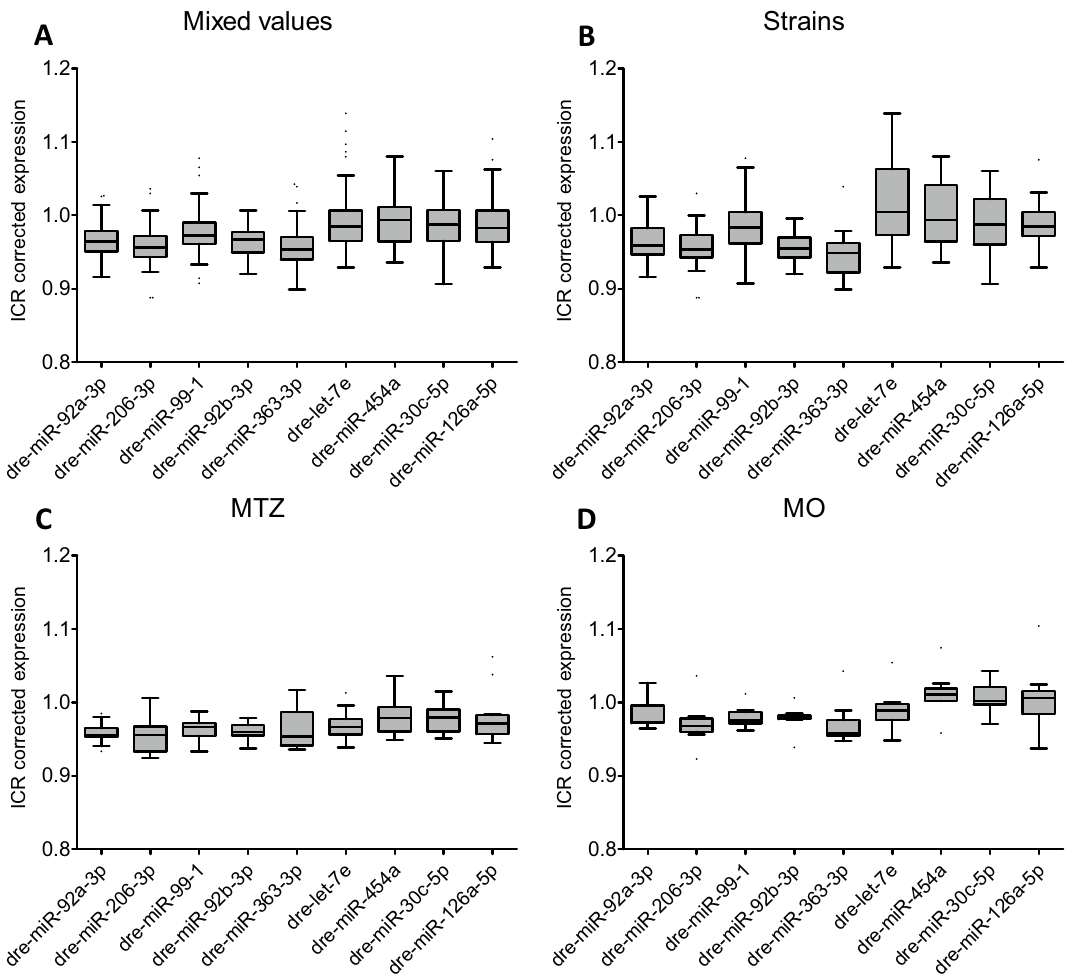
Figure 3. Abundant expression of candidate as endogenous control miRs. All miR candidates were detectable in the whole sample set. In general, they exhibit a high homogeneity as indicated by low standard deviations (SD). MiR-92b-3p shows most homogenous expression levels in mixed values ( A ), strains only ( B ), MTZ- treatment group ( C ) and in MO-treated group ( D ). Data is presented as inter-run calibrator (ICR) corrected expression. Box-Whisker plots with upper and lower quartiles and outliers from technical triplicates. ( A ) 45 samplings of 20 pooled larvae; ( B ) 21 samplings of 20 pooled larvae; ( C ) 15 samplings of 20 pooled larvae; ( D ) 9 samplings of 20 pooled